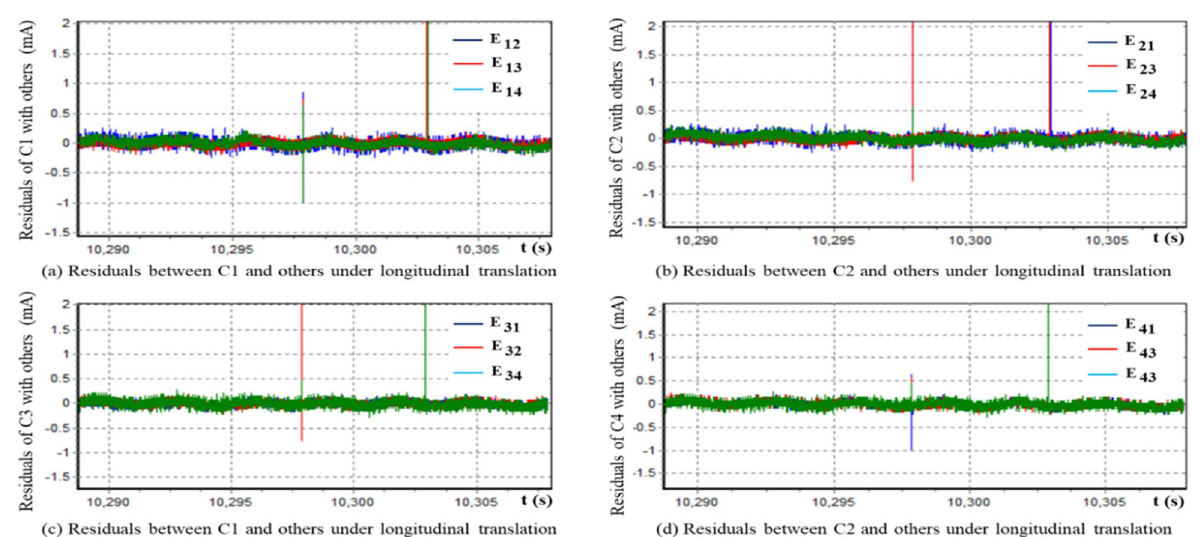
Figure 2. Residuals of sampling current of four reaction wheel motors under longitudinal translation.